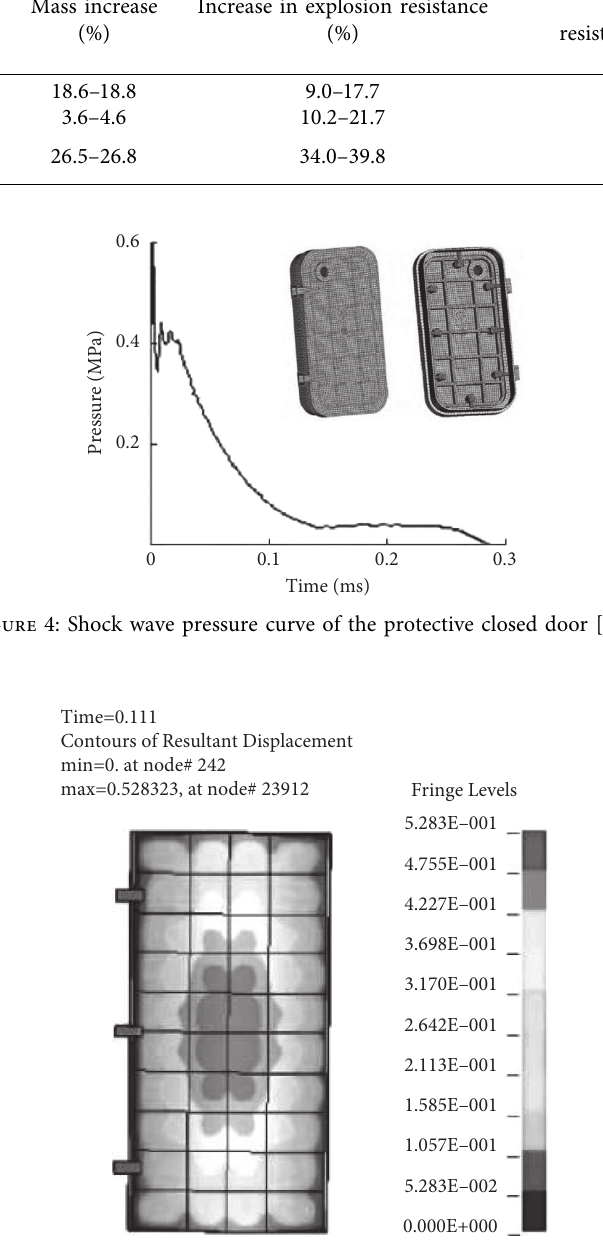
Figure 5: Maximum displacement